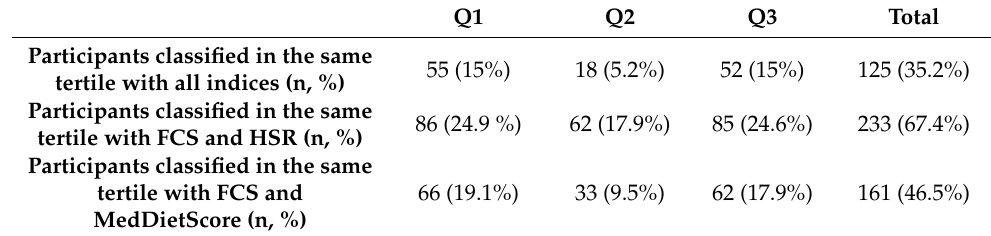
Table 4. Classification of participants in the same tertile for FCS, HSR, and